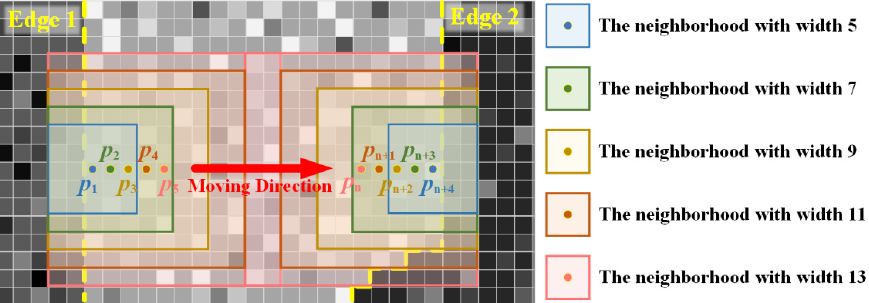
Figure 5. The simulated performance of the scale-adaptive neighborhood.